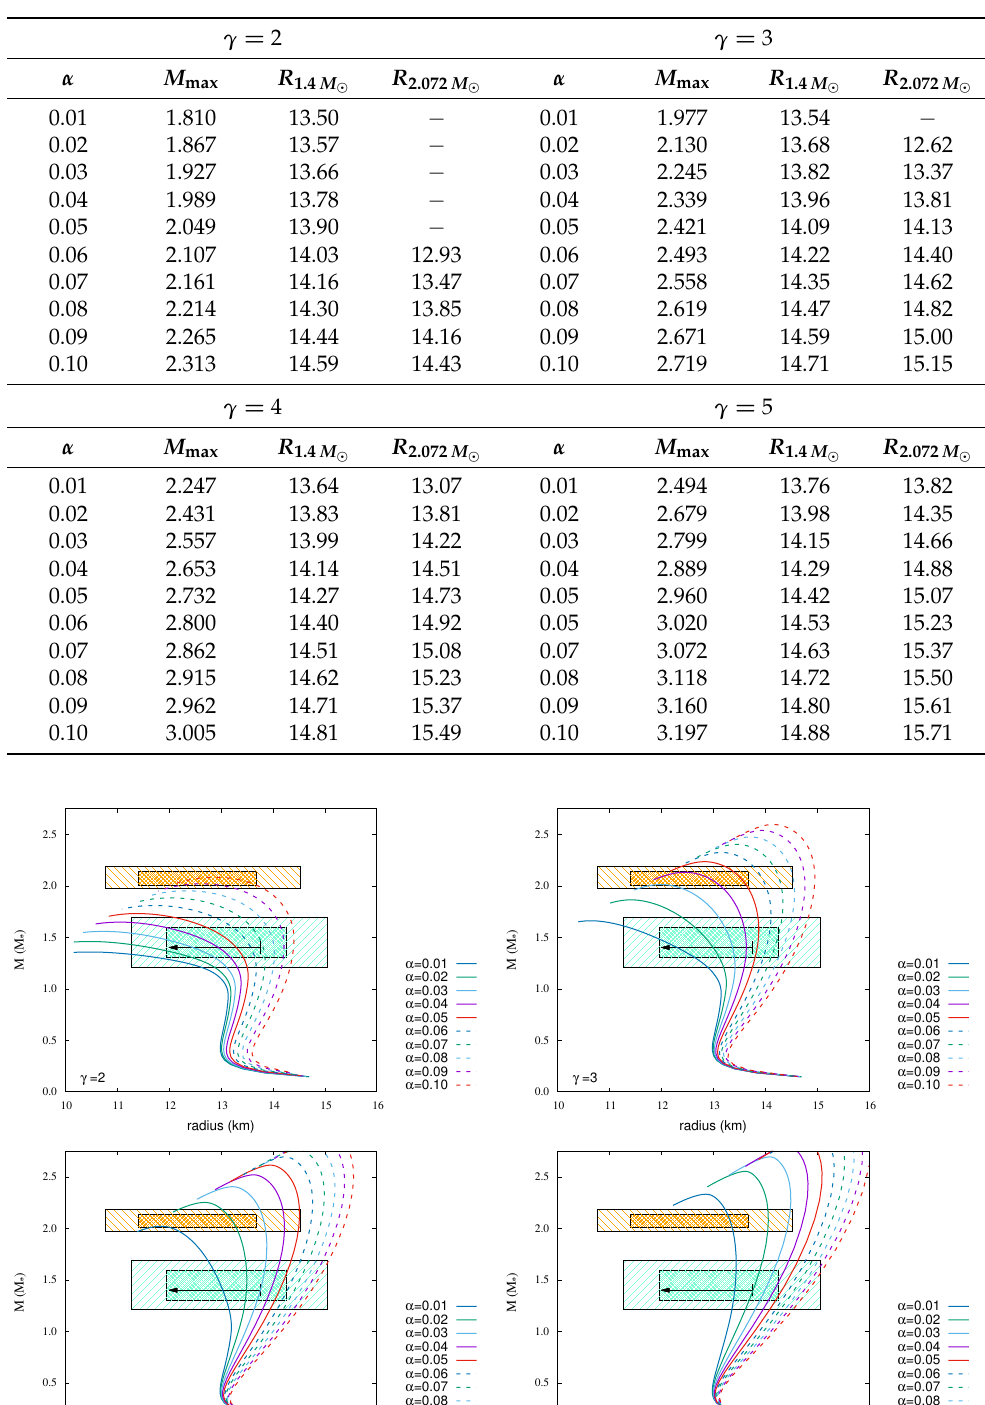
) and radius (cid:12)